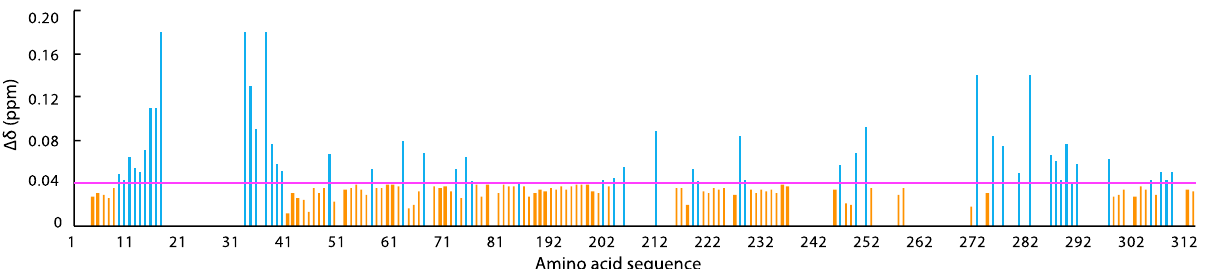
Fig. 6 Binding of hAtg3 Δ 90-190_P21A to bicelles induces structural changes different from the wild-type protein. a , b Overlay of TROSY spectra of 2 H, 15 N, 13 C-labeled hAtg3 Δ 90-190 (blue) and hAtg3 Δ 90-190_P21A (red) in aqueous solution (pH 7.5) and in bicelles (DMPC:DMPG:DHPC = 4:1:20, molar ratio, pH 7.5), respectively. Both spectra were acquired on a Bruker 600 MHz spectrometer at 25 °C. c and d Plots of chemical shift differences ( Δ δ ) between hAtg3 Δ 90-190 and hAtg3 Δ 90-190_P21A against residue numbers in aqueous solution and in bicelles,